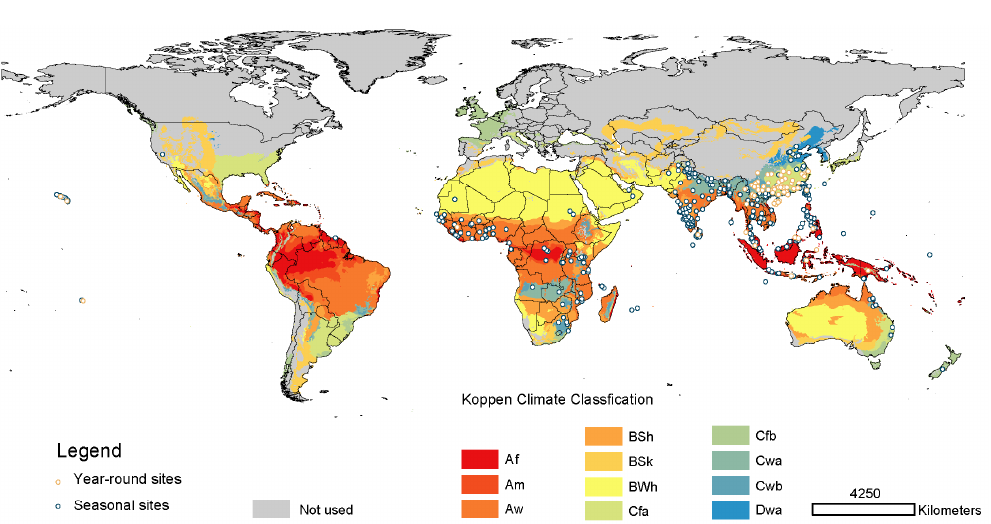
Figure 1. Seasonal and year-round occurrence points of populations of Bactrocera dorsalis used in the modeling process. Colors refer to Köppen–Geiger classifications, while the grey areas represent areas not used in models. The letter codes for climate classes are as follows. Af: equatorial rainforest,